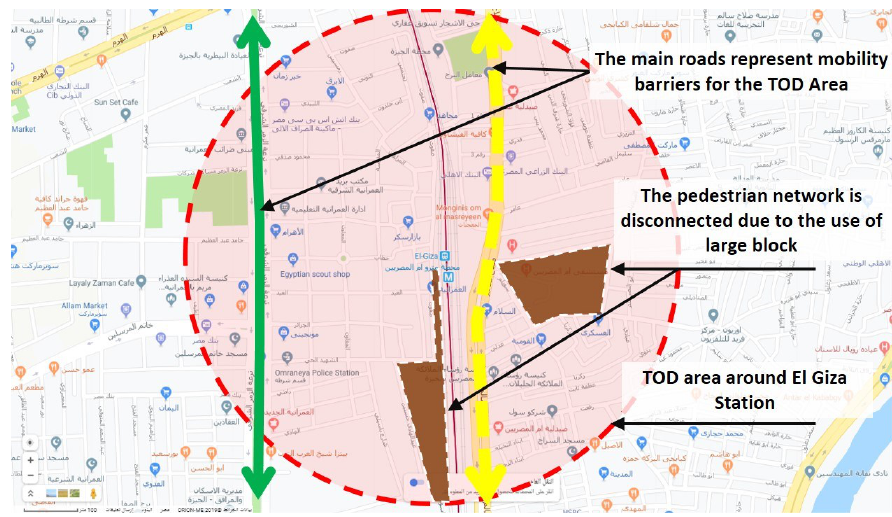
Figure 7. analysis of TOD area for El-Giza metro Station – Source the